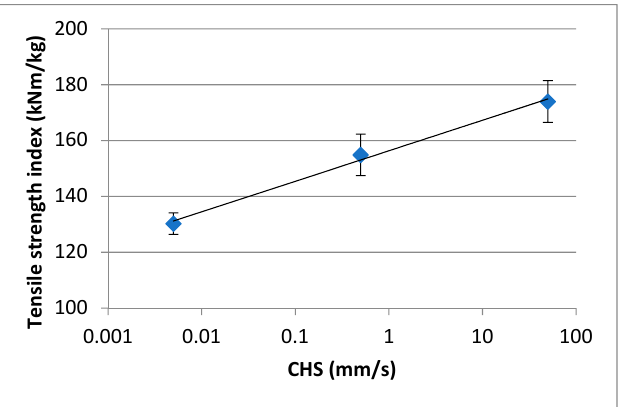
Figure 1. The effect of cross-head speed on the tensile strength of a nanocellulose